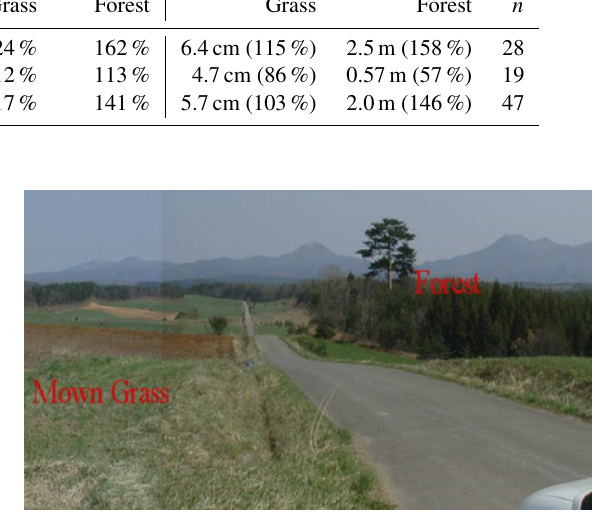
Figure 2. Image of the two areas (grassy and forested) used in roughness survey